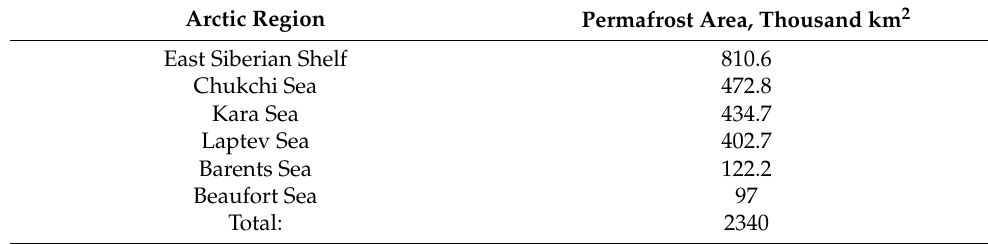
Table 4. Permafrost areas in some regions of the Arctic shelf.